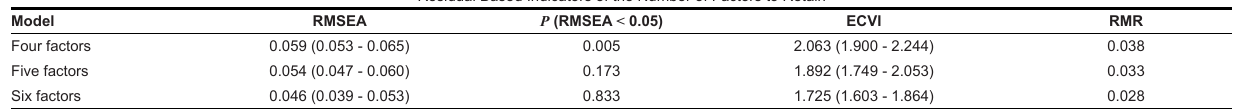
TABLE 1 Residual Based Indicators of the Number of Factors to